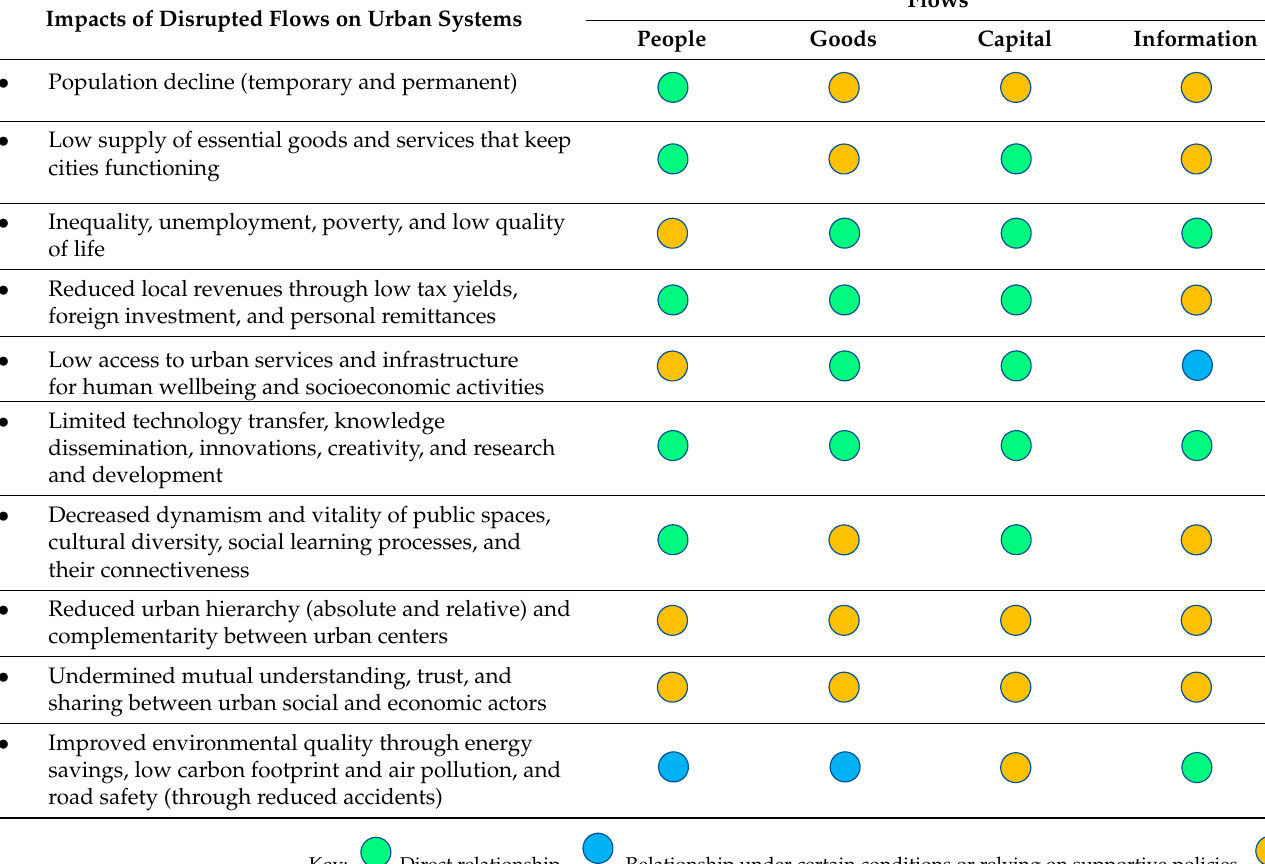
accidents) Key: Direct relationship. Relationship under certain conditions or relying on supportive Key: Direct relationship. Relationship under certain conditions or relying on supportive policies. Indirect or induced relationship. policies. Indirect or induced relationship. Key: Direct relationship. Relationship under certain conditions or relying on supportive Direct relationship. Relationship under certain conditions or relying on supportive Key: Direct relationship. Relationship under certain conditions or relying on supportive policies. Indirect or induced relationship. policies. Indirect or induced relationship. policies. Indirect or induced relationship. Direct relationship. Relationship under certain conditions or relying on supportive policies. Indirect or induced relationship. Direct relationship. Relationship under certain conditions or relying on supportive Key: Direct relationship. Relationship under certain conditions or relying on supportive policies. policies. Indirect or induced relationship. Direct relationship. Relationship under certain conditions or relying on supportive policies. Indirect or induced relationship. Key: Direct relationship. Relationship under certain conditions or relying on supportive policies. Indirect or induced relationship.